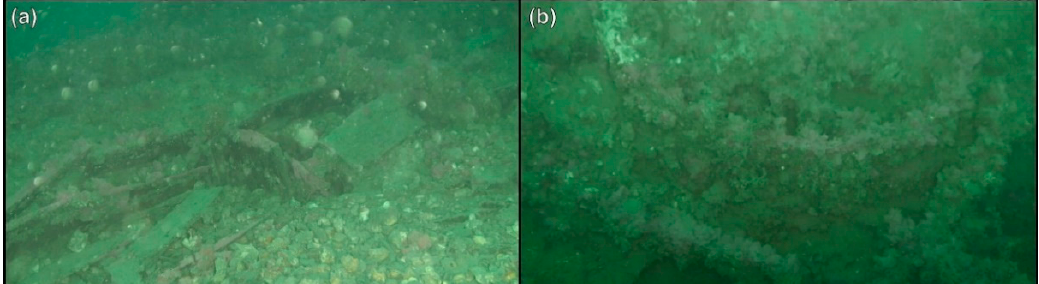
Figure 5. Screenshots from the 2015 mini-remotely operated vehicle (ROV) high-definition (HD) video. Panel ( a ) shows the remains of two barrels with lids, and panel ( b ) shows a part of a mechanical metal construction (wheel) completely covered with barnacles.